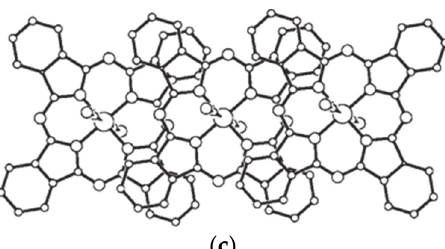
Figure 4. ( a ) The molecular structure of a metal phthalocyanine (MPc) [M(Pc)(CN) 2 ] n unit (0 ≤ n ≤ 1); ( b ) A typical crystal structure of Cat[M(Pc)X 2 ] 2 salts (Cat = onium monocations): (C 6 H 5 ) 4 P[Fe(Pc)(CN) 2 ] 2 ; ( c ) A close-up view of a 1D column of [Fe(Pc)(CN) 2 ] 0.5 − . Reproduced from Ref. [559] with permission from The Royal Society of Chemistry .